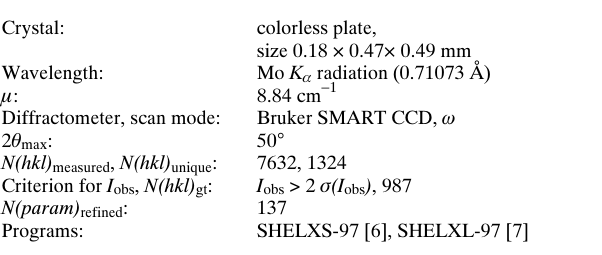
Table 1. Data collection and handling.